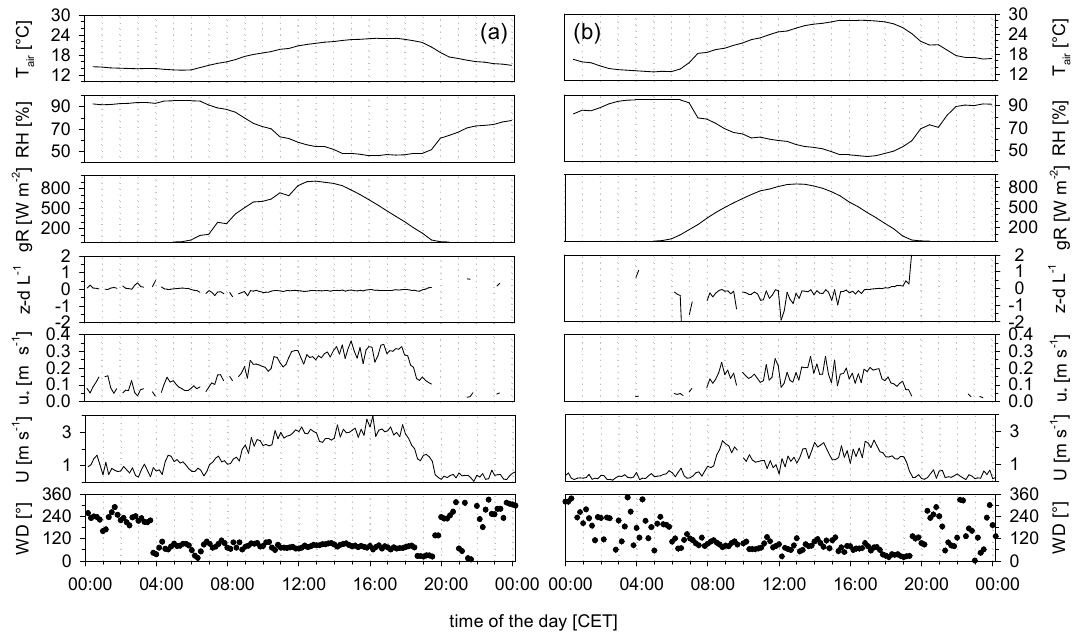
Fig. 2. Air temperature ( T air ), relative humidity (RH), global radiation (gR), stability ( z − dL − 1 , z − d =1m, where z =measurement height, d =displacement height, L =Obukhov length), friction velocity ( u ∗ ), wind speed ( U ) and wind direction (WD) ( T air , RH, gR, WD and U measured at 3ma.g.l.; L and u ∗ measured at ∼ 1ma.g.l.) on (a) 4 August 2009 and (b) 6 August